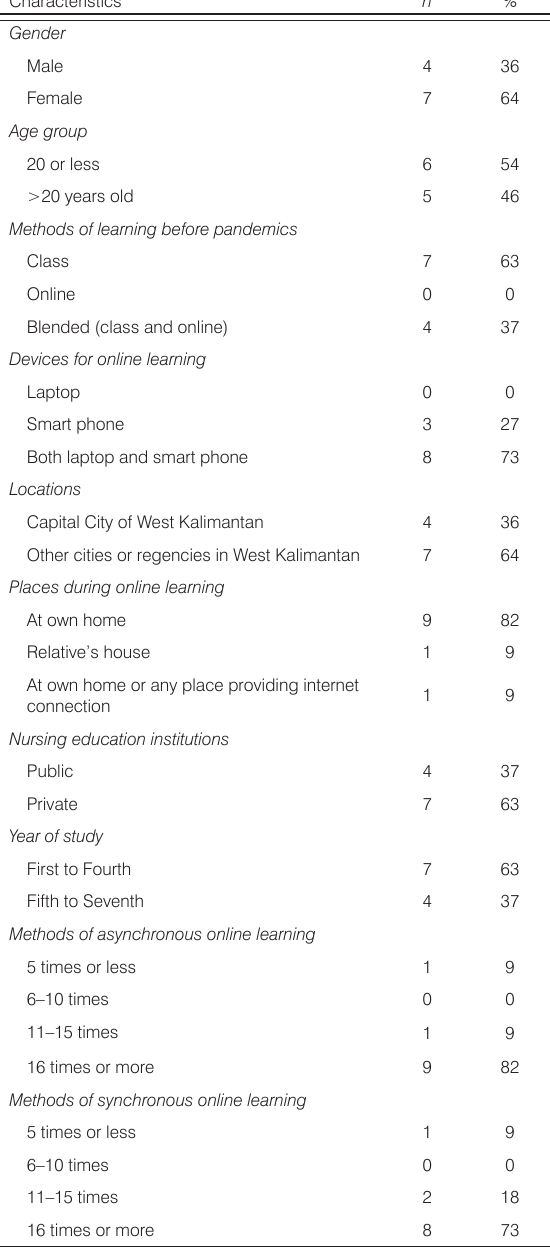
Table 1. Participant demographic characteristics ( N =